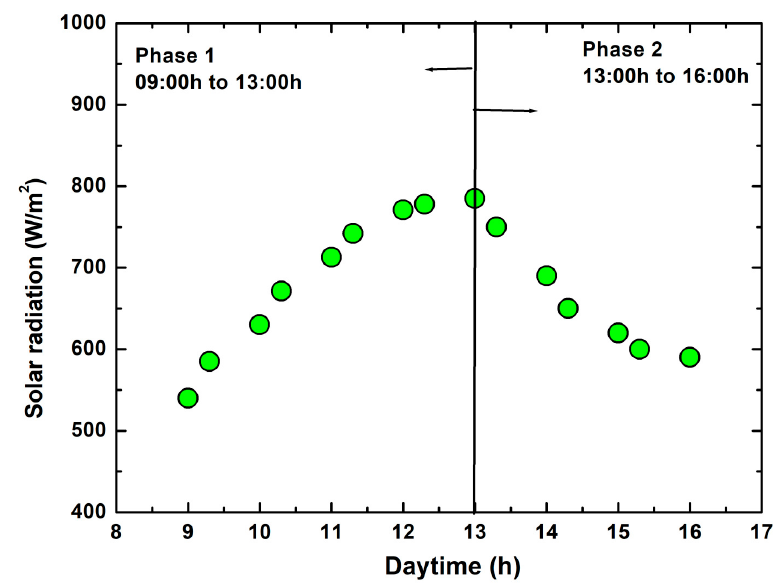
Figure 9. Solar radiation with respect to daytime.